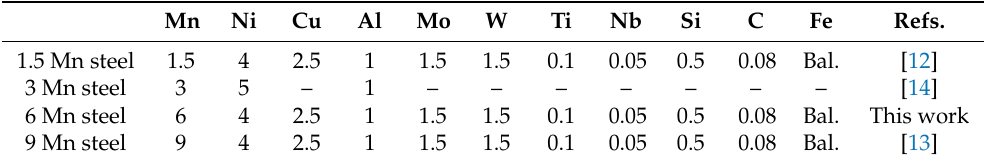
Table 1. The main chemical compositions for Cu/NiAl nanoprecipitation and grain size of the steels in this study and the referred